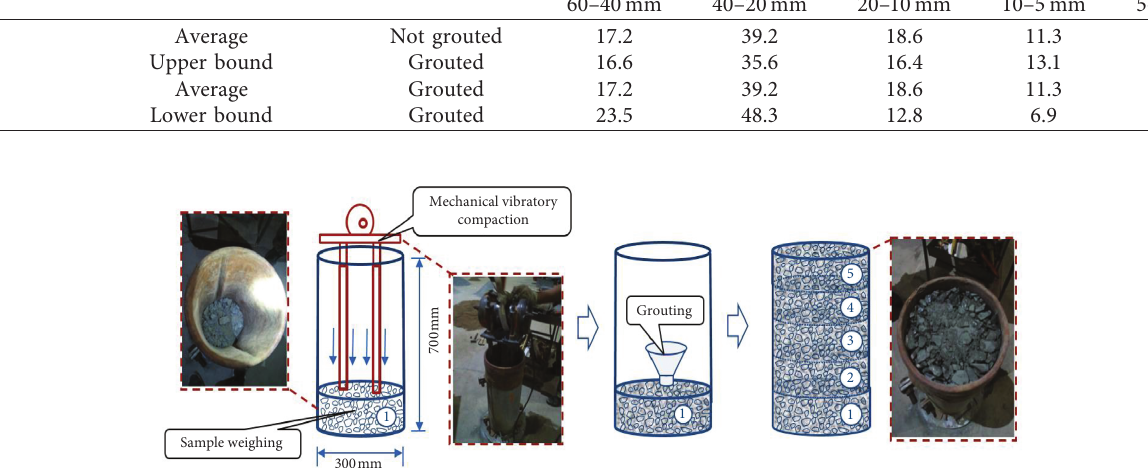
Table 1: Sequential numbers of mechanical test groups after grouting reinforcement and the mass percentages of particle size fractions at different gradation levels. Test no.